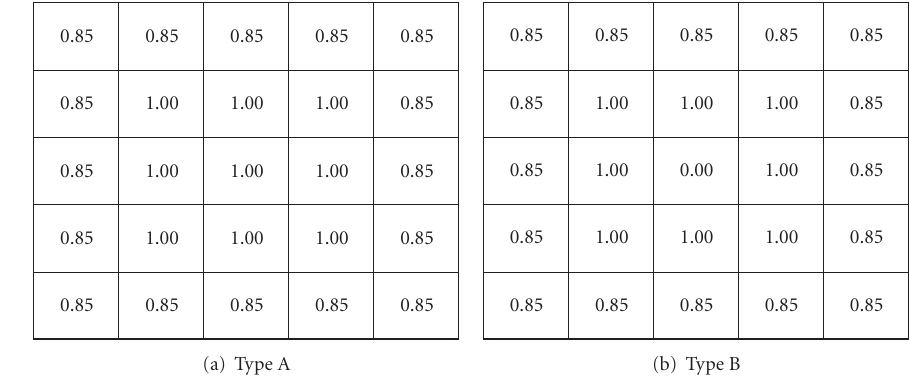
Figure 10: Radial power distribution [2].